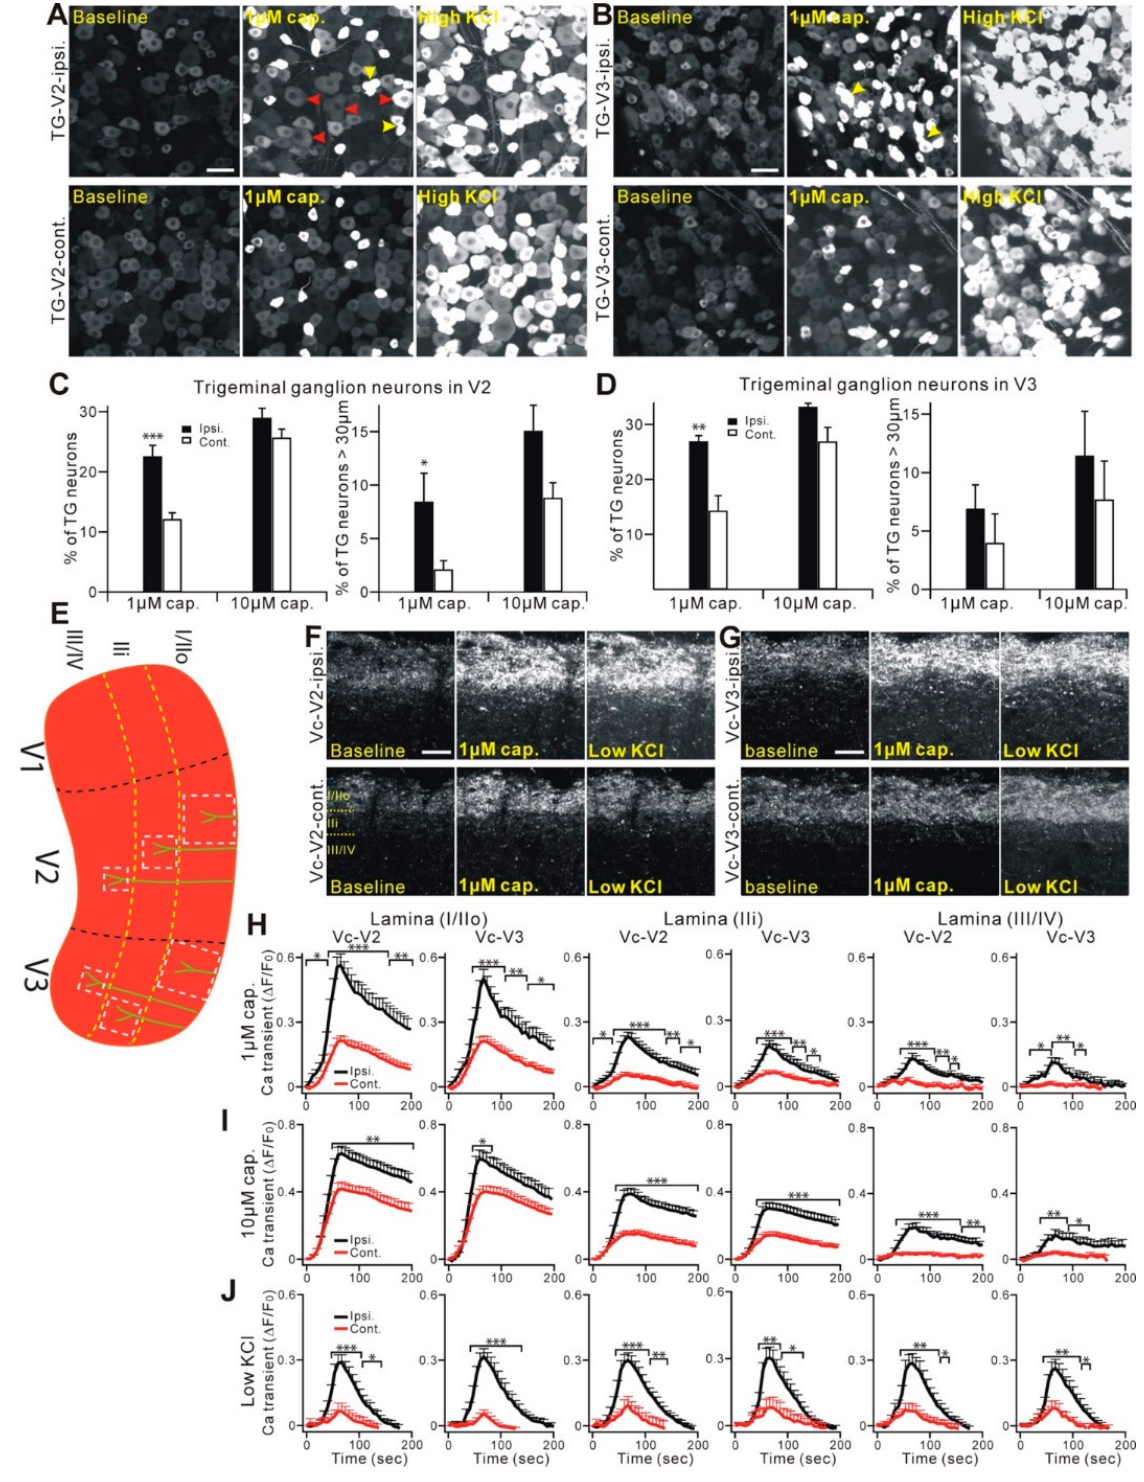
Figure 5. Functional plasticity changes of the trigeminal nociceptors following a craniofacial neuropathic injury. ( A , B ) Representative GCaMP3 imaging of TG explants from Pirt-GCaMP3 mice. TG neurons of V2 ( A ) or V3 ( B ) division after CCI-ION were activated by capsaicin (1 µM) or KCl (100 mM). Upper panels show ipsilateral a V2 ( A ) or V3 ( B ) division of TG. Lower panels show a contralateral V2 ( A ) or V3 ( B ) division of TG. Scale bar, 50 µm (for both). Arrowheads in red indicate TG neurons that are over 30 µm in diameter and activated by capsaicin. Arrowheads in yellow indicate coupled TG activation by capsaicin; that is, adjacent neurons activated together—simultaneously or in a very short time window (<1 sec). ( C , D ) Population data for V2 shown in ( C ) or for V3 shown in ( D ), expressed as the percentage of KCl-sensitive TG neurons. ipsi., ipsilateral; cont., contralateral. * p < 0.05; ** p < 0.01; and *** p < 0.001. Data are presented as the mean ± SEM. ( E ) Schematic diagram of a mouse Vc. Black dashed lines indicate the border of three large divisions (V1, V2, and